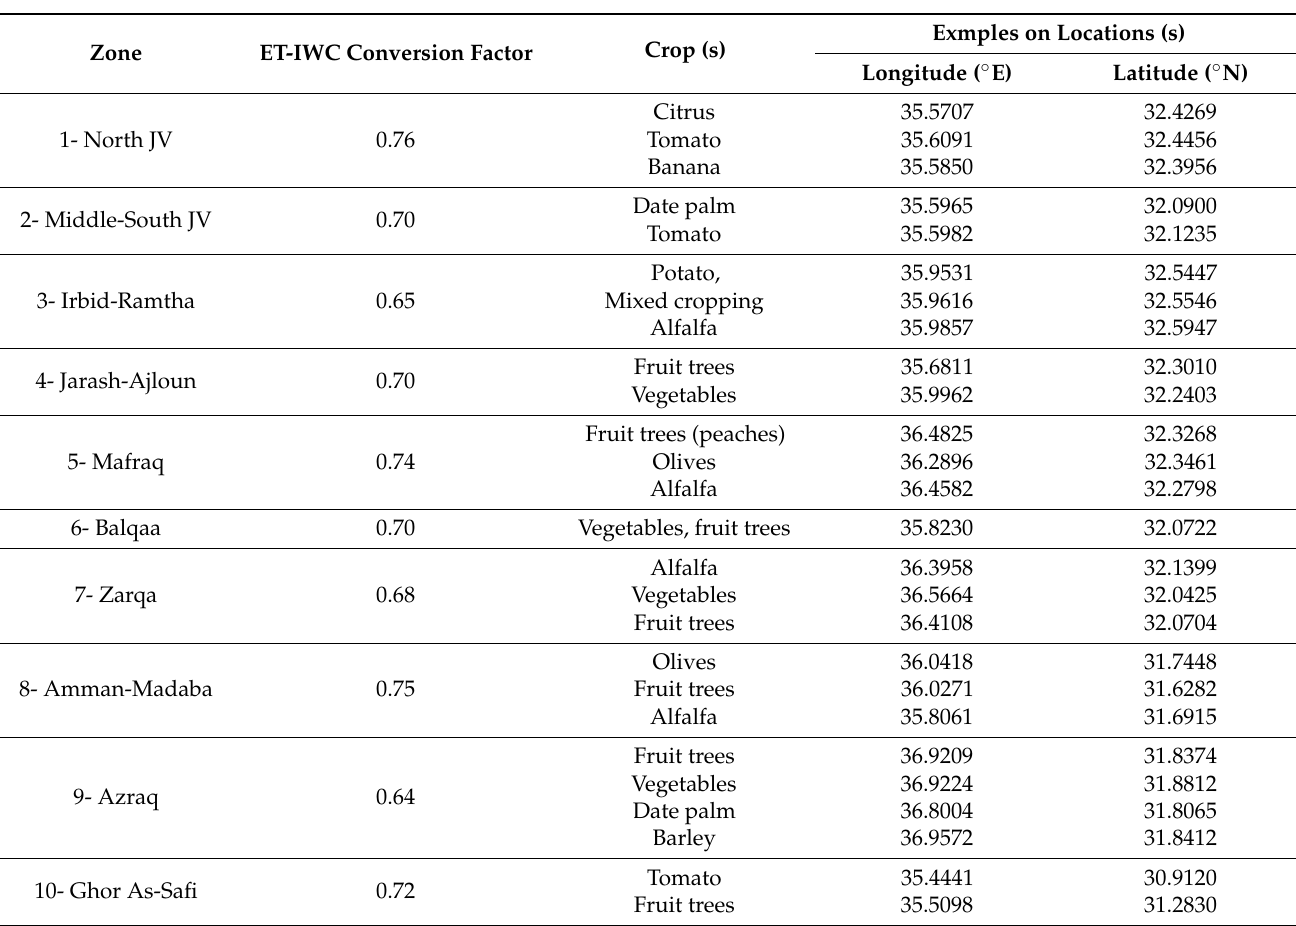
Table A2. List of conversion factors of SEBAL-ET- and NDVI-Kc-derived ET to IWC with examples of sample locations used for deriving the conversion